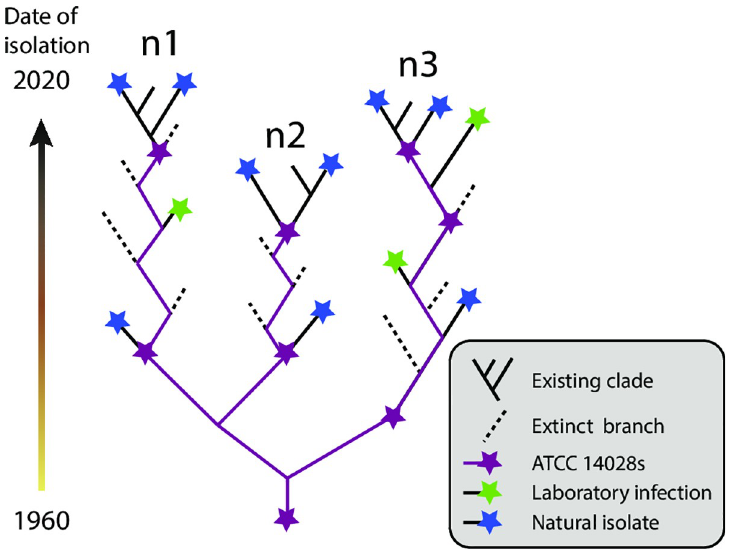
Fig 7. Cartoon of the microevolution inferred for HC20_373 since the original isolation of ATCC 14028s in 1960. Extinct branches from which genomes were not sequenced are indicated by dashed lines whereas extinct branches with genomic sequences are terminated by stars. Colors indicate sources of bacterial